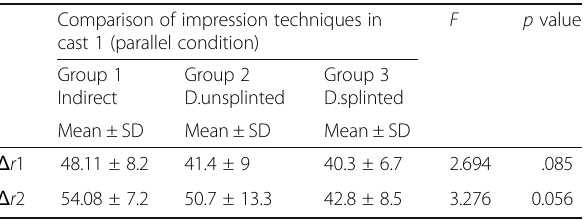
Table 2 Comparison of impression techniques in cast 1 using one-way ANOVA Comparison of impression techniques in cast 1 (parallel condition)